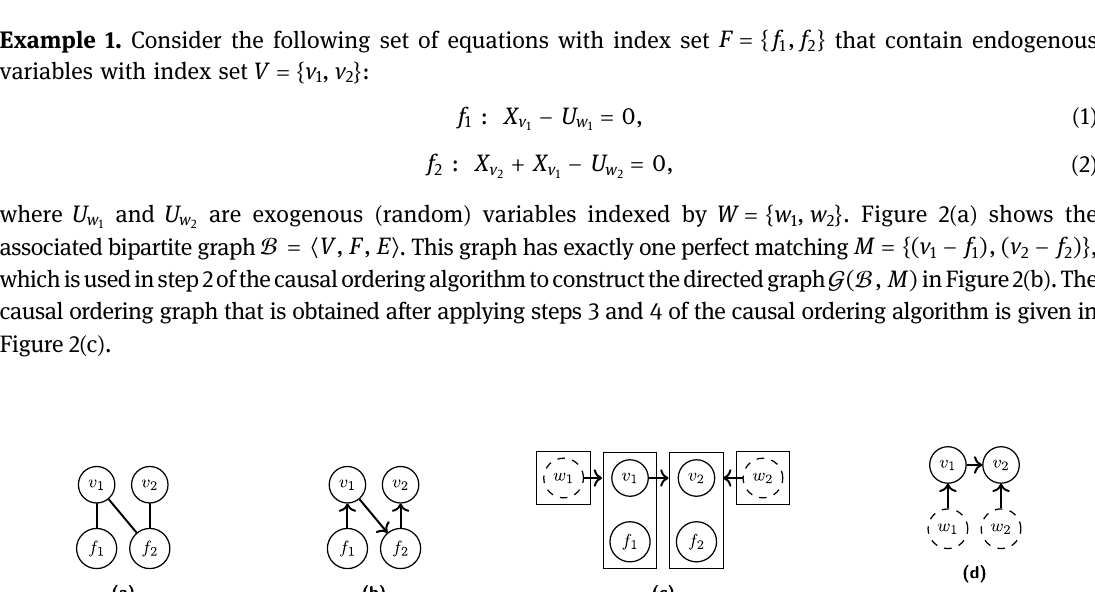
Figure 2: Several graphs occurring in Example 1. The bipartite graph (cid:2) associated with equations ( 1 ) and ( 2 ) is shown in ( a ) . The oriented graph M , (cid:5) (cid:2) ( ) obtained in step 2 of the causal ordering algorithm ( with perfect matching M ) is shown in ( b ) .